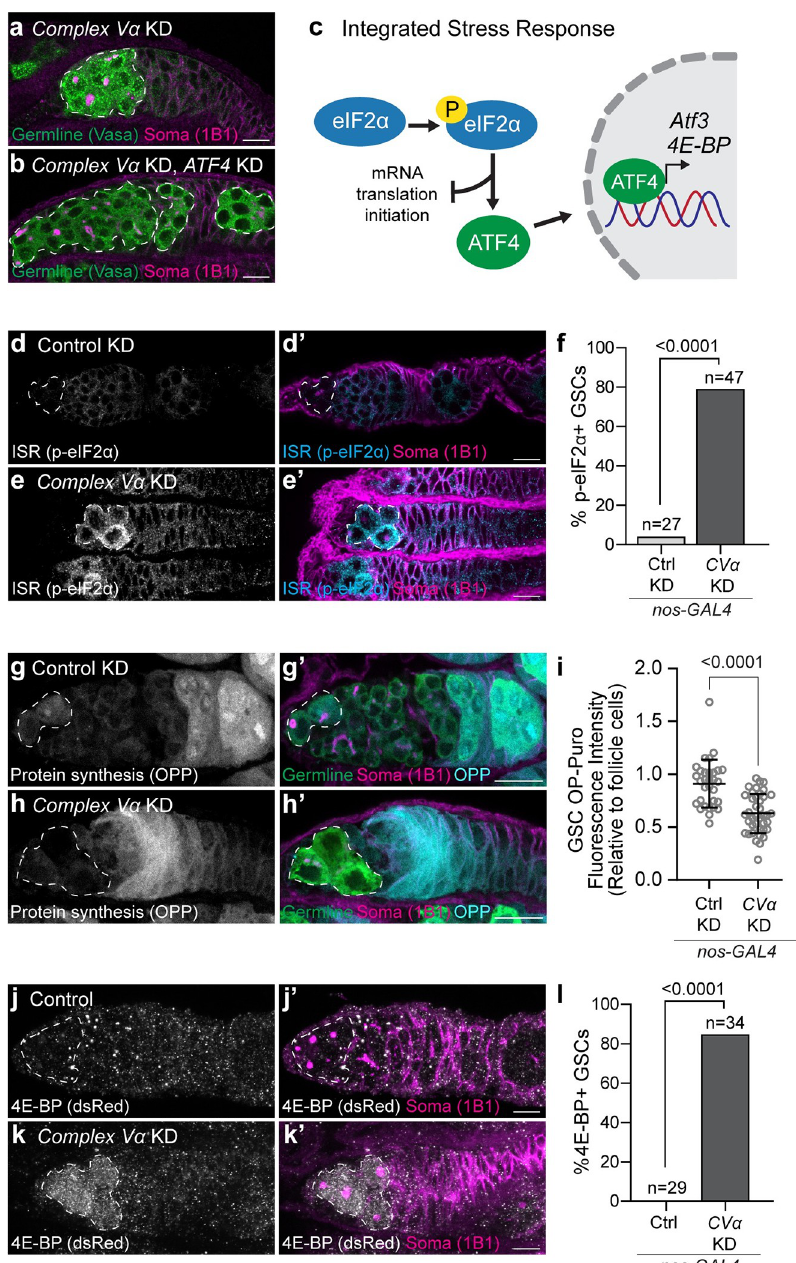
Fig 3. Complex V knockdown activates the Integrated Stress Response. (a, b) Representative images of 2–3 day old CV α KD (a) ,and CV α and ATF4 KD (b) germaria. (c) Schematic of the Integrated Stress Response (ISR). Phosphorylation of eIF2 α activates the ISR by inhibiting global cap-dependent translation and selectively upregulating the translation of the transcription factor, ATF4. ATF4 upregulates the transcription of stress responsegenes including 4E-BP and Atf3 . (d, e) Representative images of 2–3 day old Control ( mCherry ) (d) and CV α (e) KD germaria. (f) Frequency of GSCs with high phosphorylated eIF2 α relative to surrounding somatic cells from (d, e) . (g, h) Representative images of 1-day old Control ( mCherry ) (g) and CV α (h) KD germaria incubated with O-propargyl-puromycin (OPP) to visualize protein synthesis. (i) Intensity of fluorescently derivatized OPP in GSCs relative to follicle cells of Control( mCherry )KD (n = 31) and CV α KD (n = 40). Data are the mean ± s.d. and an unpaired t-test was used for statistical analysis. (j, k) Representative images of less than one week old Control (j) and CV α (k) KD germaria expressing ATF4 reporter, 4E-BP intron - dsRed. (l) Frequency of dsRed-positive GSCs in (g, h). For (f, l) number of GSC analyzed and P-value (Fisher’s exact test) are given above bars. For (a, b) white-dashed lines demark the germline, and for (d-e, g-h, j-k) white-dashed line demark GSCs. All RNAi were driven by nos-GAL4 .For exact genotypes see S2 Table.